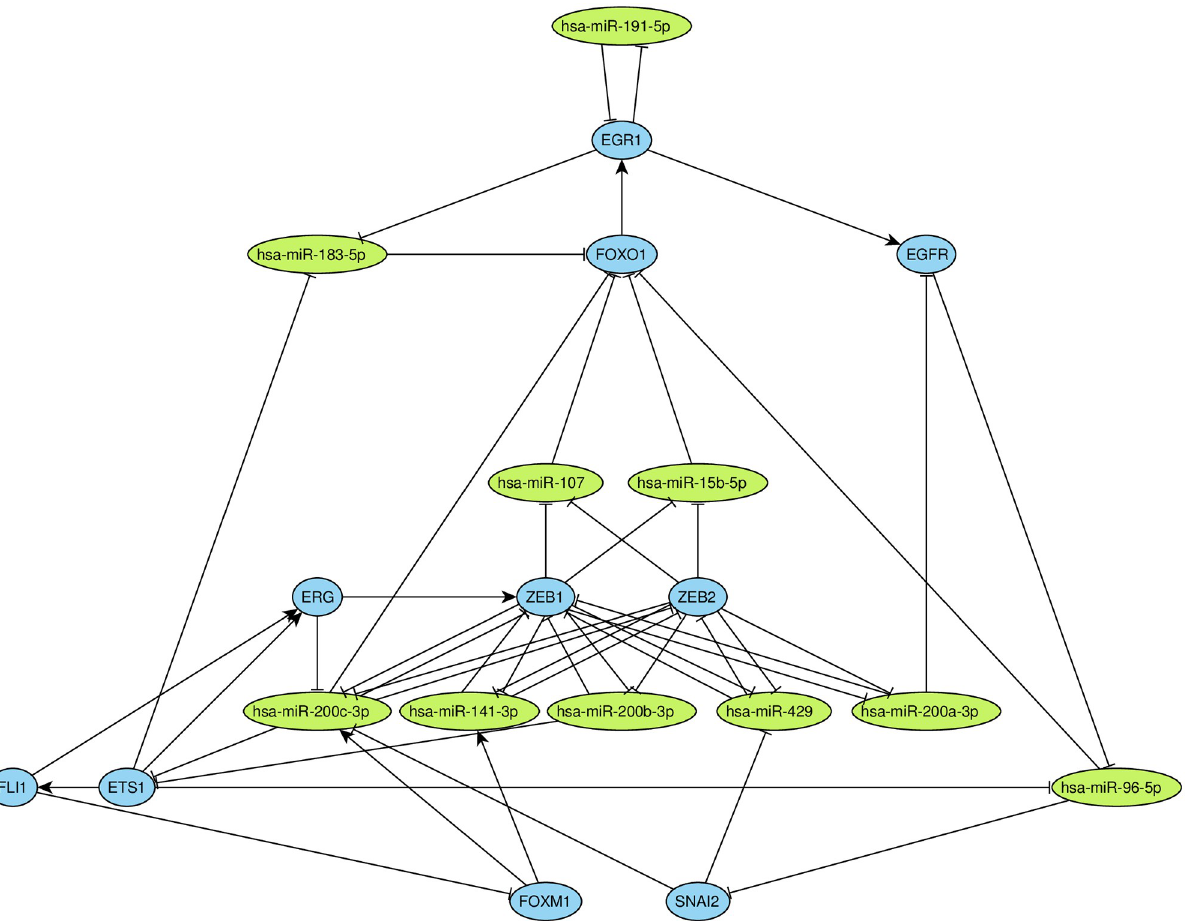
Fig 4. The second major strongly connected component. TFs are colored in blue, miRNAs are colored in green. The arrows and T-shaped lines signify activation and repression, respectively.